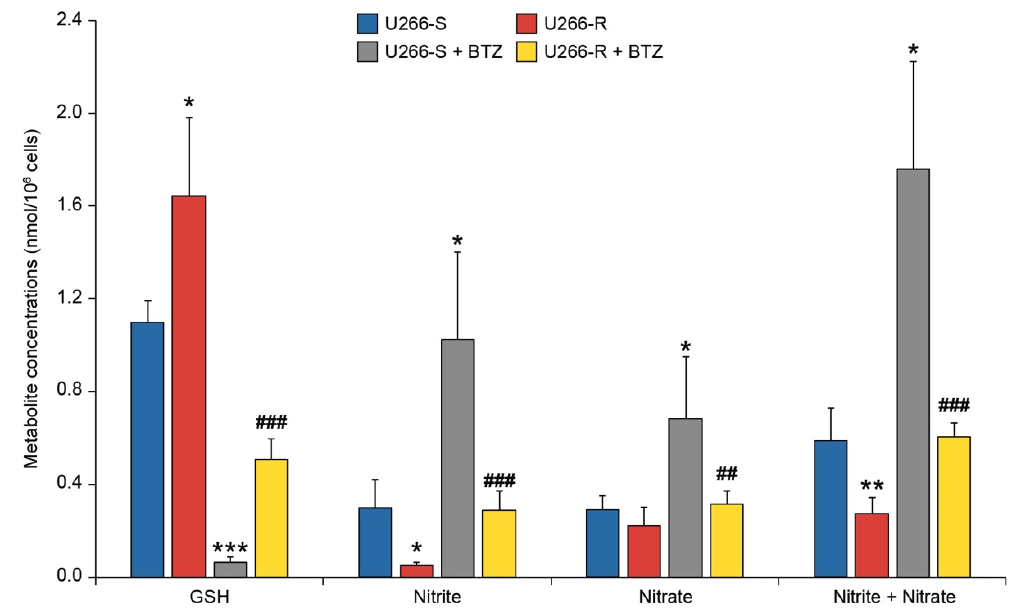
Figure 4. Concentrations of glutathione (GSH) (representative of the cell antioxidant status), nitrite and nitrate (as indicators of nitrosative stress) in sensitive versus resistant U266 exposed to BTZ. Metabolite concentrations are expressed as nmol per 10 6 cells in U266-S and U266-S + BTZ and in U266-R and U266-R + BTZ. Data are shown as mean ± SEM of n = 4 biological replicates; * p -value < 0.05, ** p -value < 0.01 and *** p -value < 0.001 versus U266-S; ## p -value < 0.01 and ### p -value < 0.001 versus U266-S + BTZ.